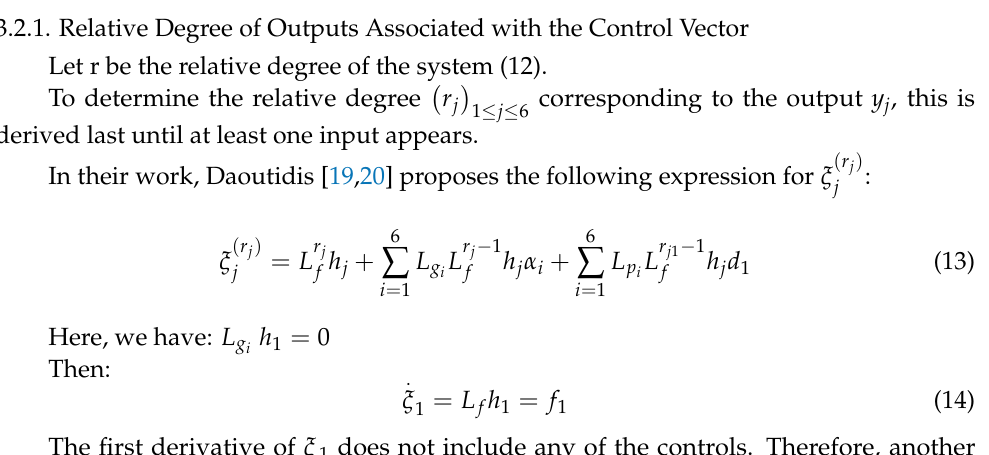
Figure 4. Control method of feedforward/feedback